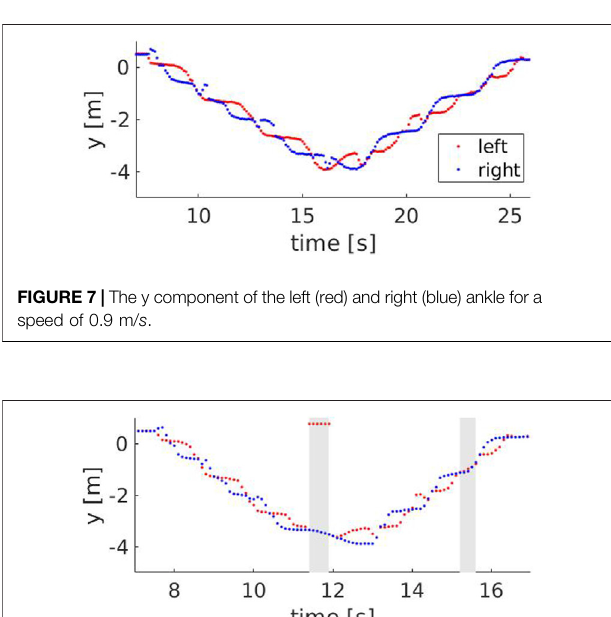
Frontiers in Robotics and AI |